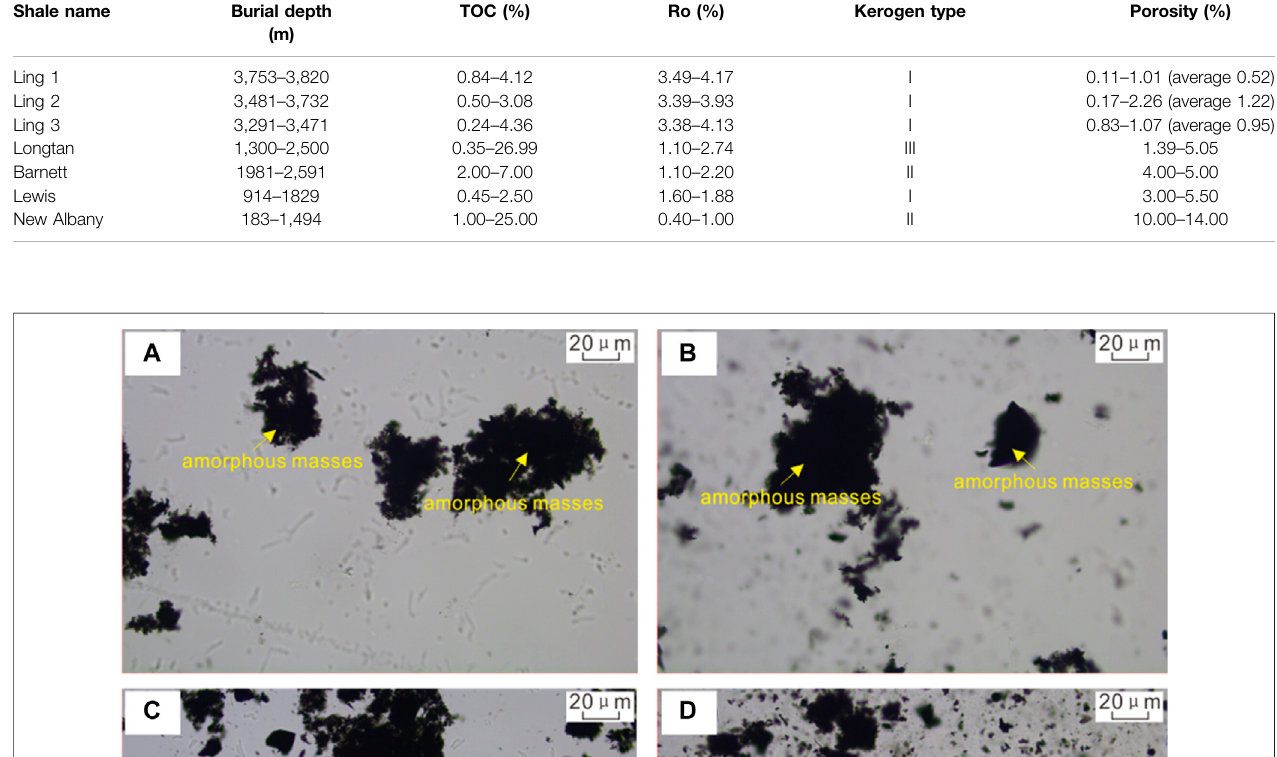
Frontiers in Earth Science |